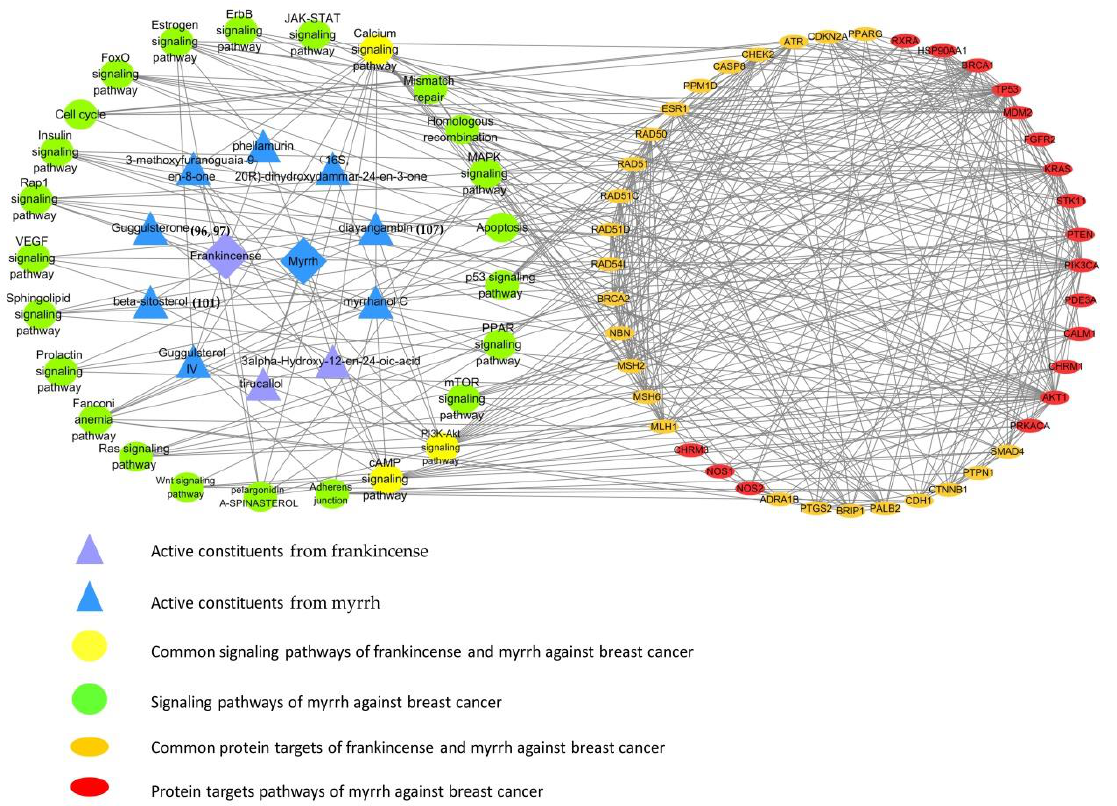
Figure 7. Active constituent-protein targets-signaling pathway network of frankincense–myrrh compound against breast cancer.